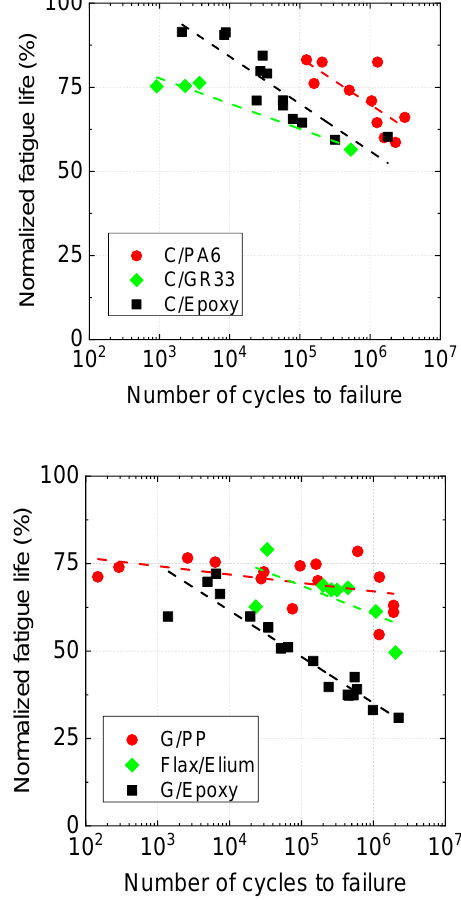
Fig. 6. Normalized S-N plots for all 6